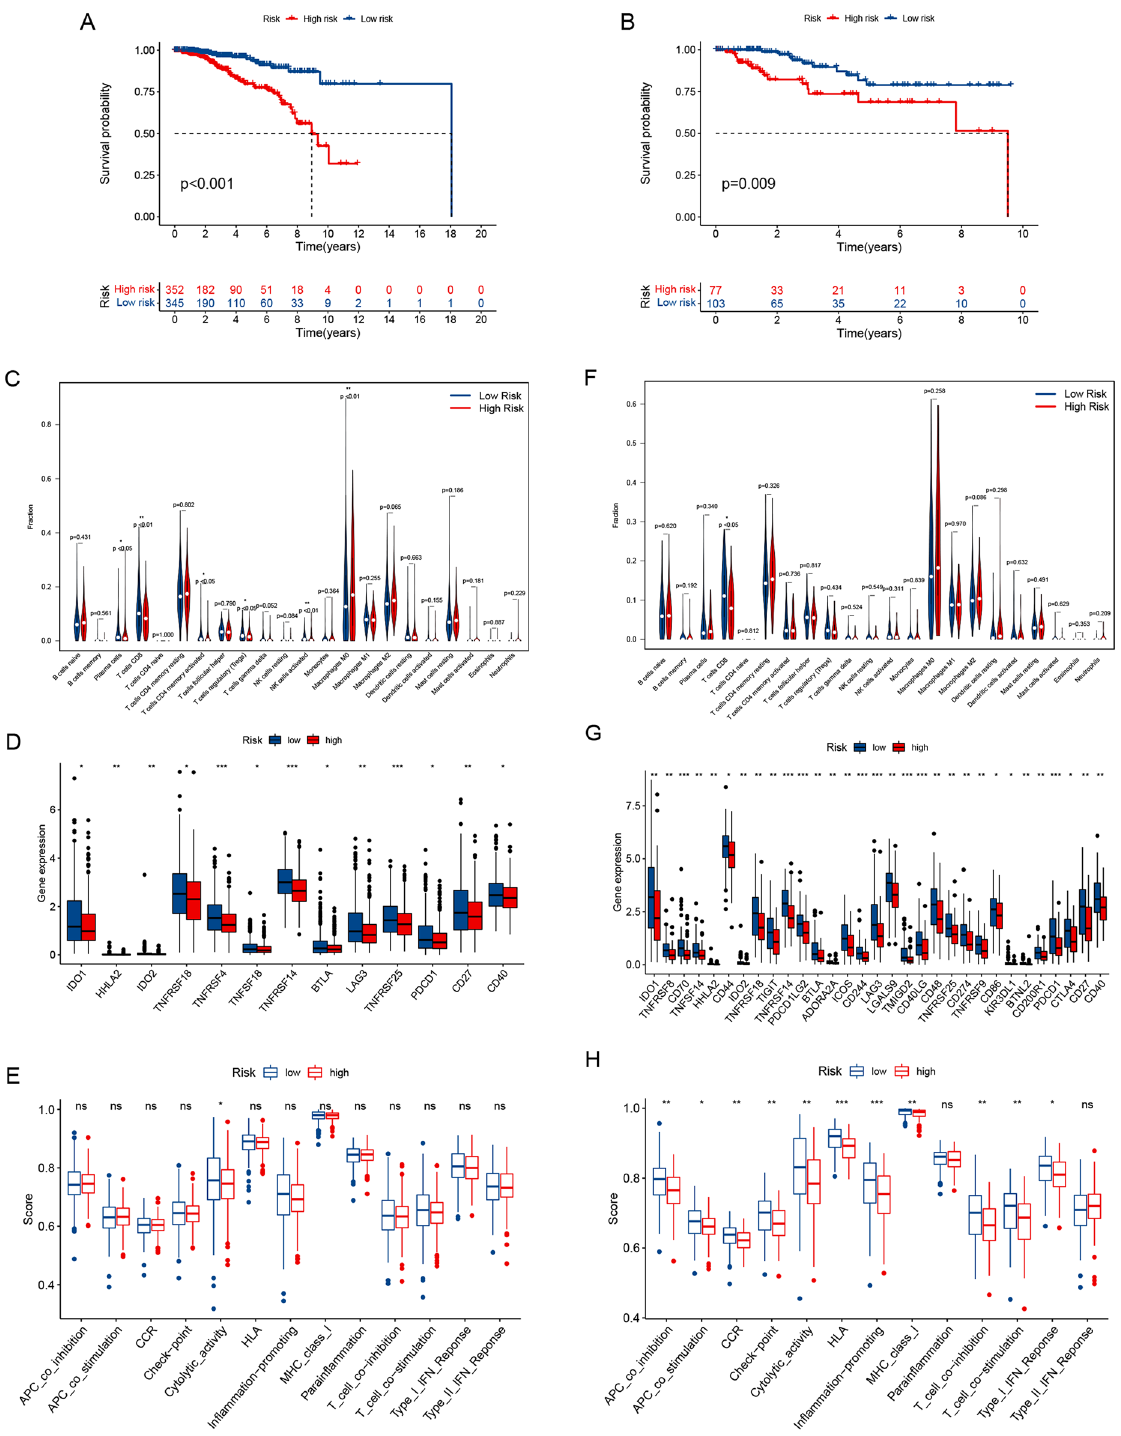
Figure 9. The overall survival and immune cell infiltration landscape in luminal or non-luminal subtypes of BRCA. Kaplan–Meier curves for the overall survival of patients in the higher- and lower-risk groups in luminal BRCA ( A ) and non-luminal BRCA ( B ). The violin plot showed the different proportions of tumor-infiltrating cells between higher-risk and lower-risk groups in luminal BRCA ( C ) and non-luminal BRCA ( F ). The expression levels of immune checkpoint molecules in the higher-risk and lower-risk groups in luminal BRCA ( D ) and non-luminal BRCA ( G ). The scores of immune functions in the higher-risk and lower-risk groups in luminal BRCA ( E ) and non-luminal BRCA ( H